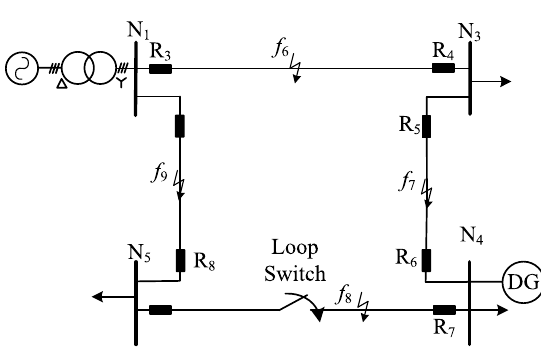
Fig. 11 Active distribution network model in closed loop